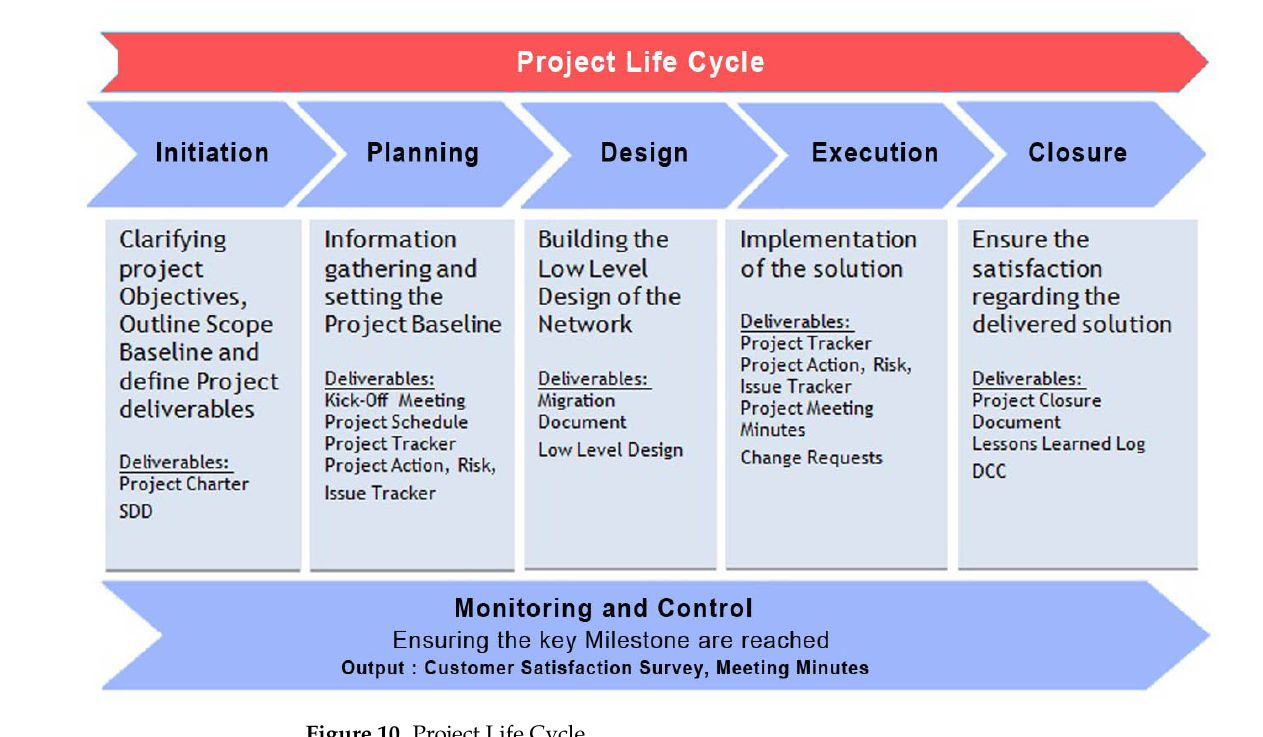
Figure 10. Project Life Cycle.